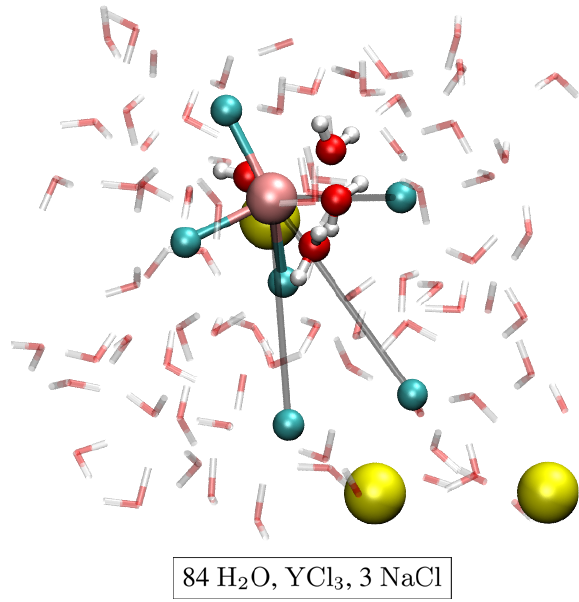
Figure 1. Snapshot of simulation cell A1 with a [ YCl 3 ( H 2 O ) 4 ] aq complex. The water molecules are indicated by red–white bond sticks, sodium by yellow balls and chlorine by cyan balls. The H 2 O in the first hydration shell of the yttrium atom (copper colored) is presented as red–white balls and sticks. The constraint distances be- tween the yttrium ion and the constraint Cl − are colored in